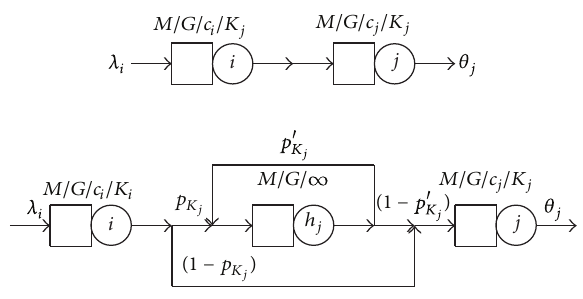
Figure 1: The generalized expansion